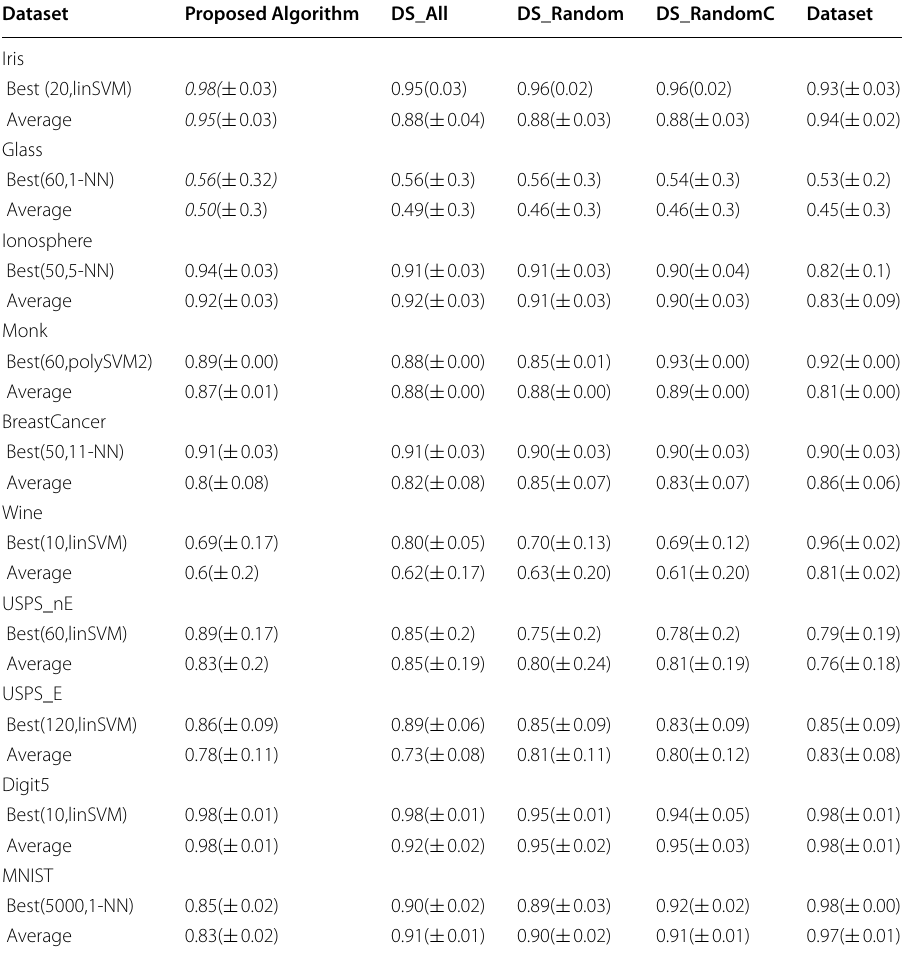
Table 6 Classification F1-score of the proposed method and other basic dissimilarity spaces Dataset